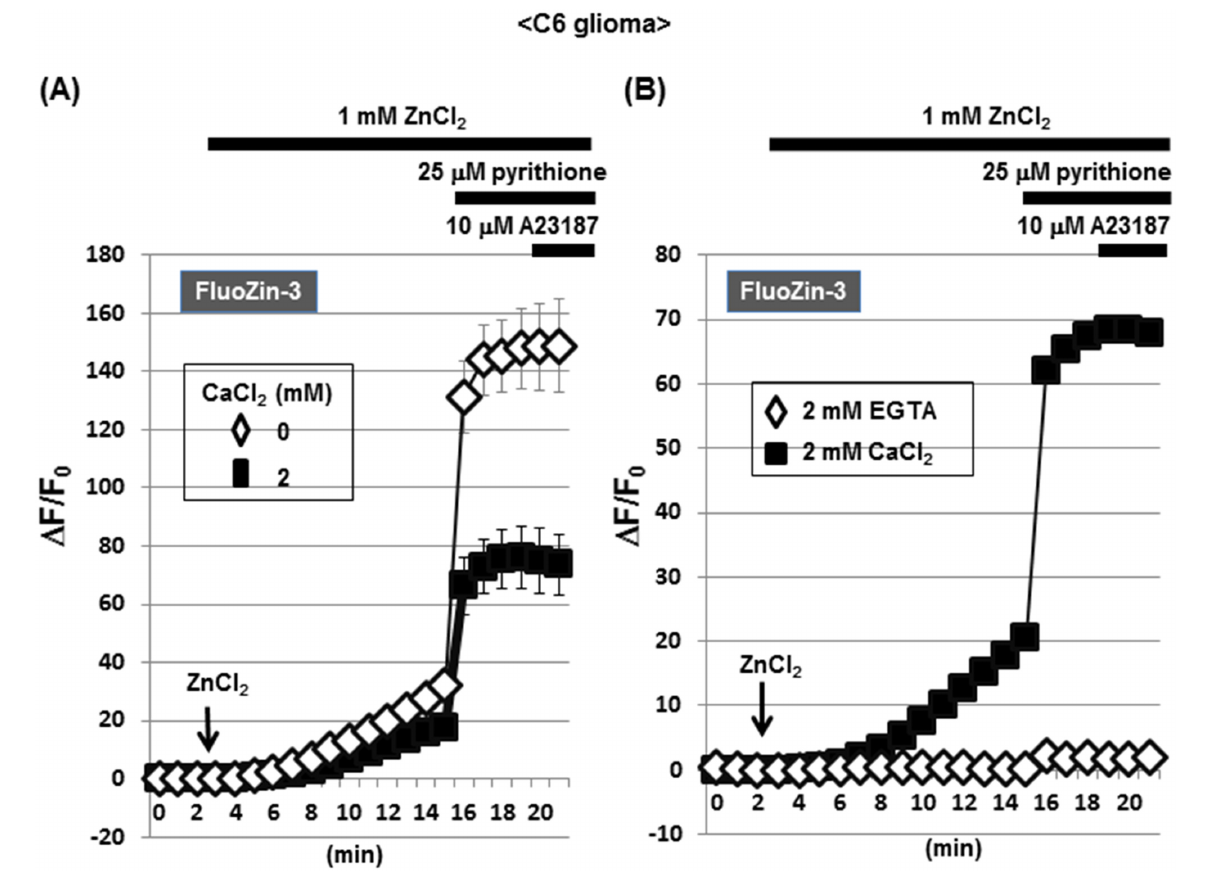
Fig 8. Effects of ZnCl 2 on FluoZin-3 fluorescence in C6 glioma cells. (A) C6 glioma cells were loaded with FluoZin-3 in either the presence or absence of CaCl 2 , followed by determination of the fluorescence intensity in the presence of ZnCl 2 every 1 min. (B) Cells were loaded with FluoZin-3 in the presence of either EGTA or CaCl 2 , followed by determination of the fluorescence intensity in the presence of ZnCl 2 every 1 min. Values are the mean ± S.E. of the rate of fluorescence change in 3 different experiments.